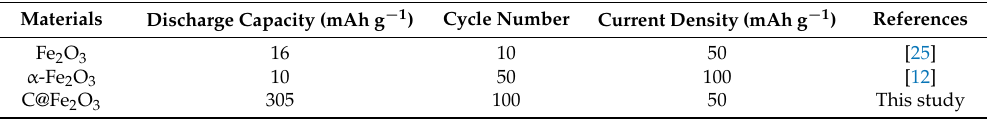
Table 1. Comparison of the electrochemical performances of Fe 2 O 3 and C@Fe 2 O 3 composite for sodium-ion